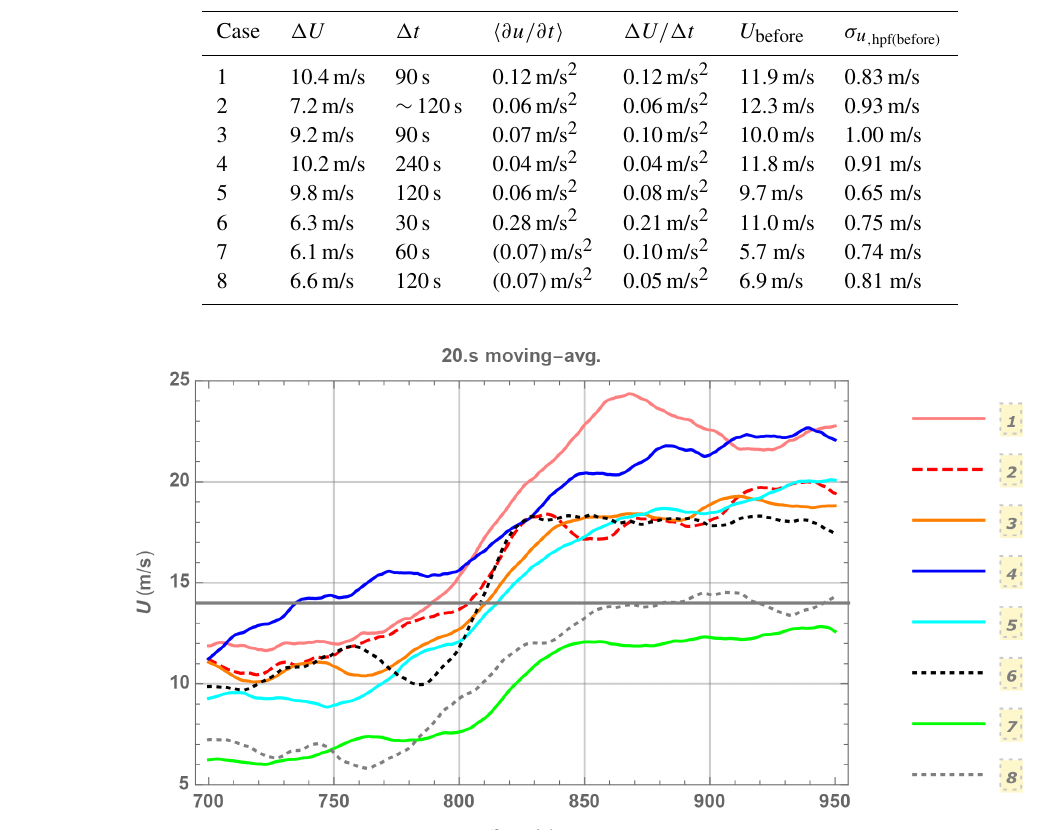
Figure 9. Wind speed at hub height, for ramps in the stochastic constrained Mann-model simulations (CMM). Horizontal gray line indicates rated wind speed. Ensemble-member (case) numbers indicated on the